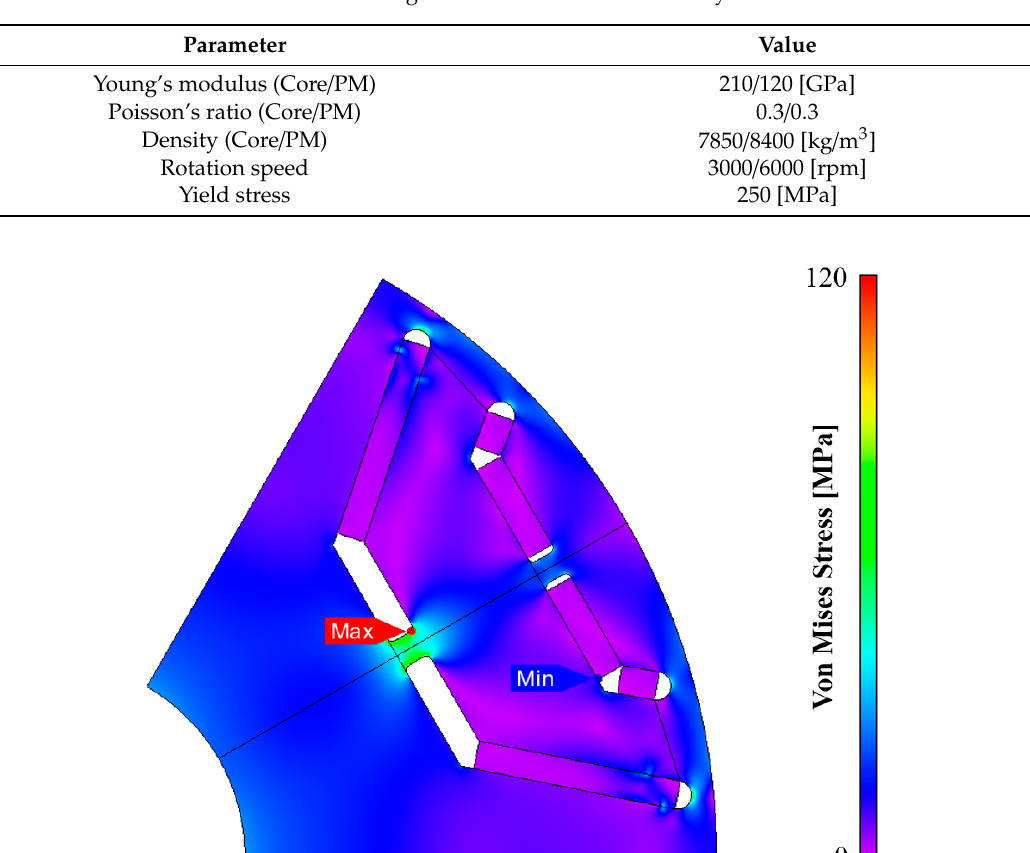
Table 8. Setting for the mechanical stress analysis.